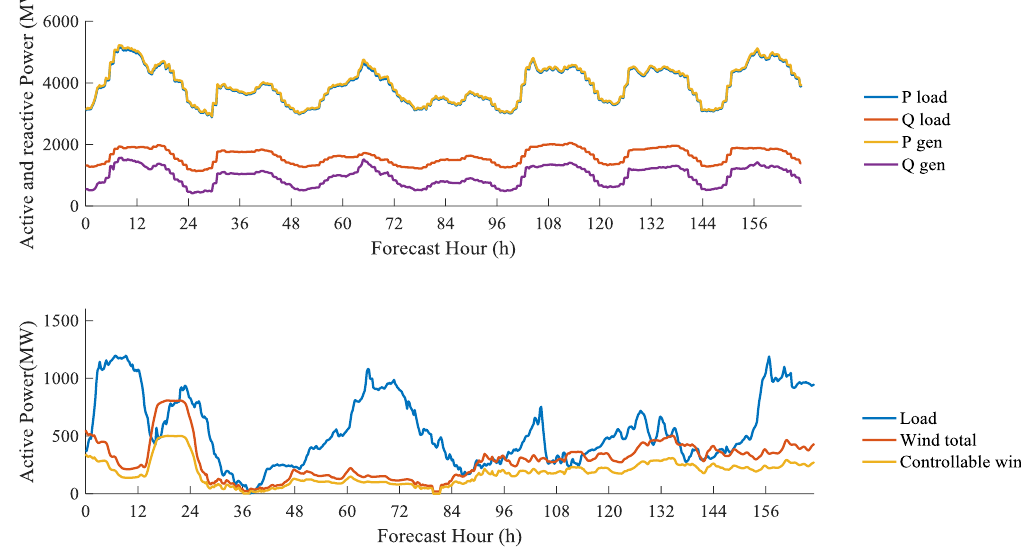
Figure 11. Weekly load and generation profile in the overall system ( top ) and in the distribution system ( bottom ).